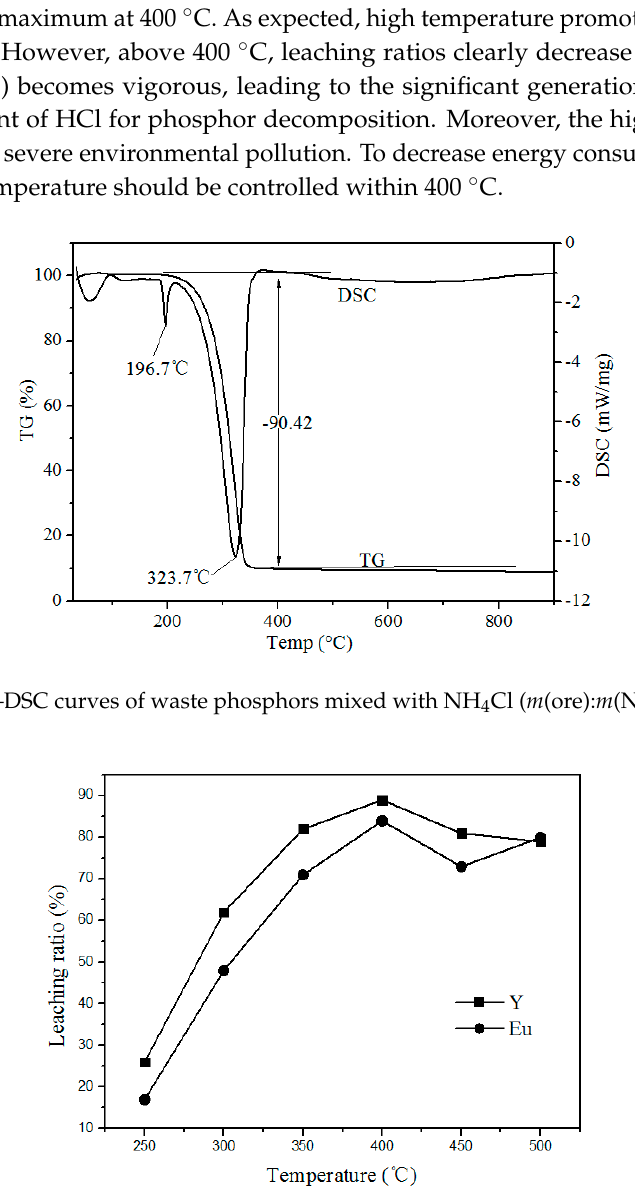
Figure 5. Effect of roasting time on the leaching rate of the rare earths.